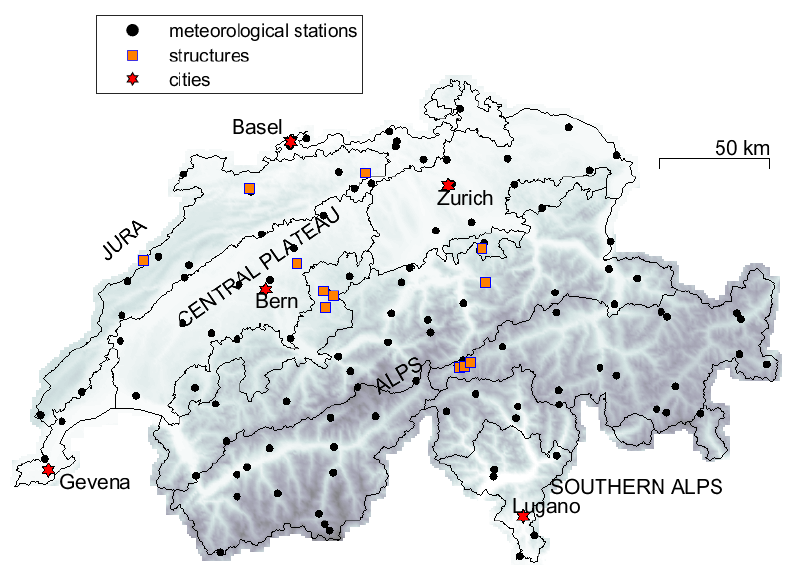
Figure 1. Overview of the meteorological stations including regions, indications of altitude (light denotes low altitude; dark denotes high altitude), and the locations of some of the country’s important cities.